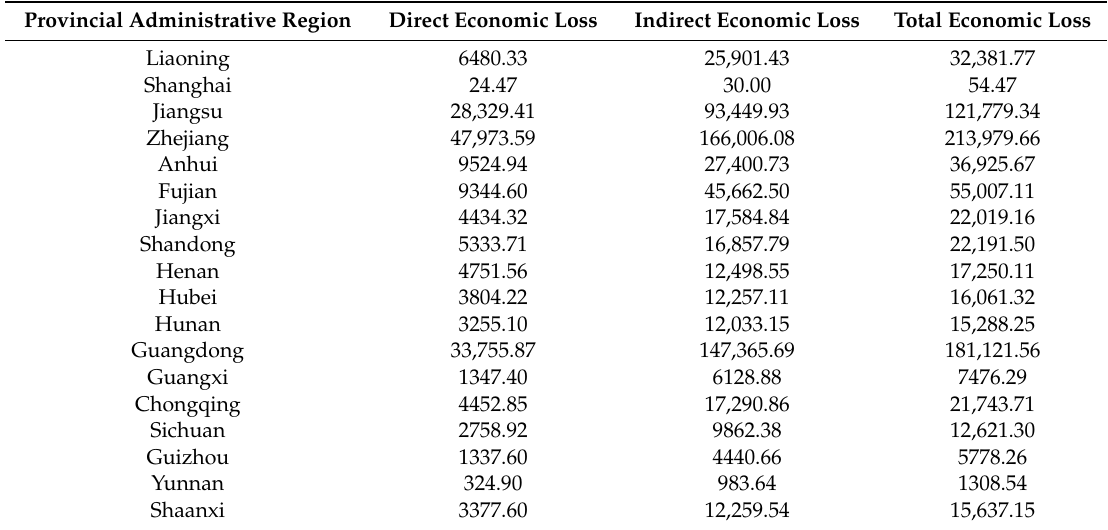
Table A8. Economic losses on the provincial level in mainland China from 1998 to 2017 / 10 4 yuan.